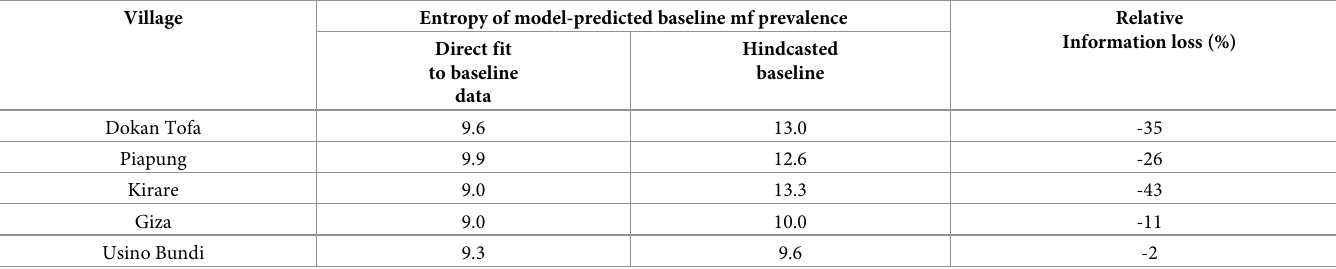
Table 2. Entropy of model fits to baseline data compared to model hindcasts of baseline.